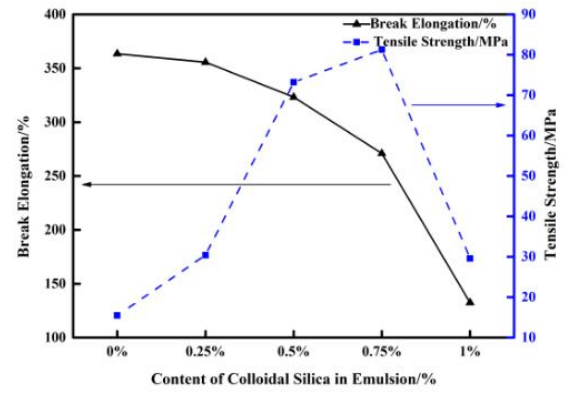
Fig. 4. mechanical properties curves of WPUA and SiO 2 -NH 2 -GO/WPUA films